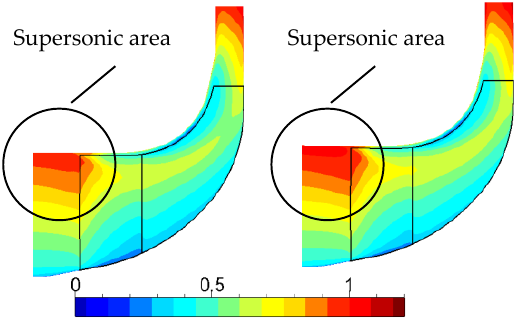
Figure 6. Relative Mach number distribution at the meridional averaged surface ( left : plain right : plateau).